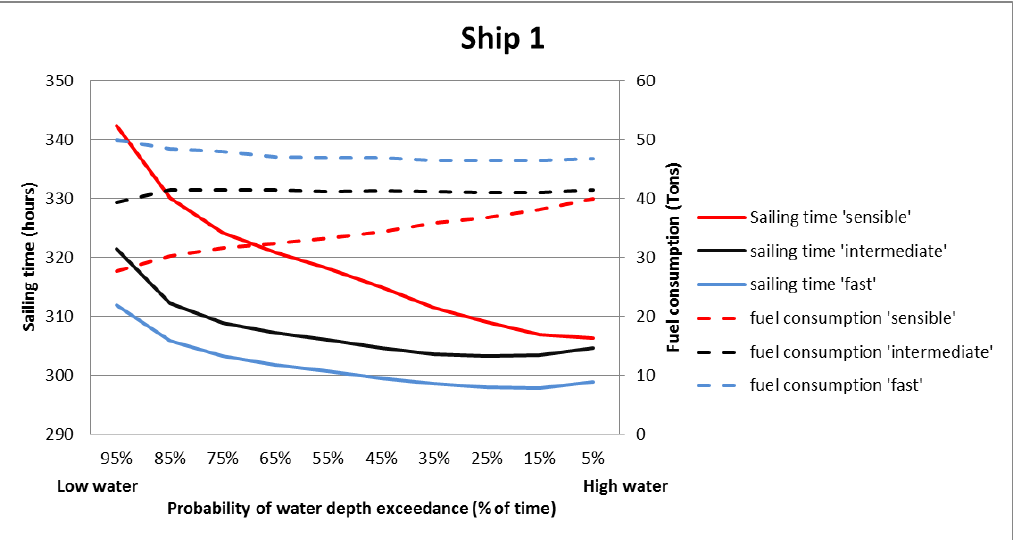
Figure 8. Impact of sailing strategies on fuel consumption and sailing times - ship